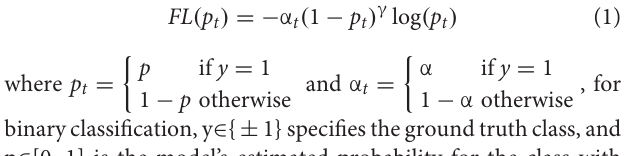
Frontiers in Plant Science |